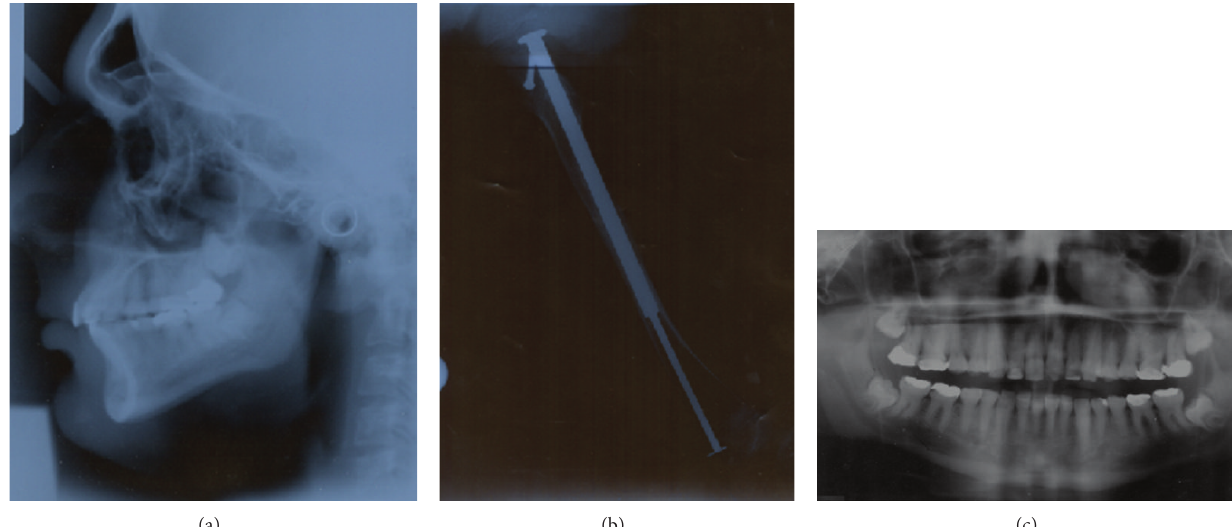
Figure 4: Patient radiographs: Lateral cephalograph (a); plain femoral radiograph (b); and orthopantomograph (OPG) (c).